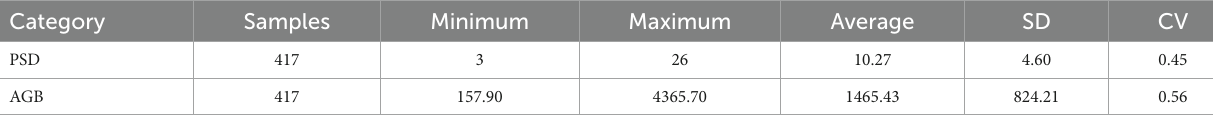
TABLE 1 Descriptive statistics of the PSD and AGB data of the measured grassland.